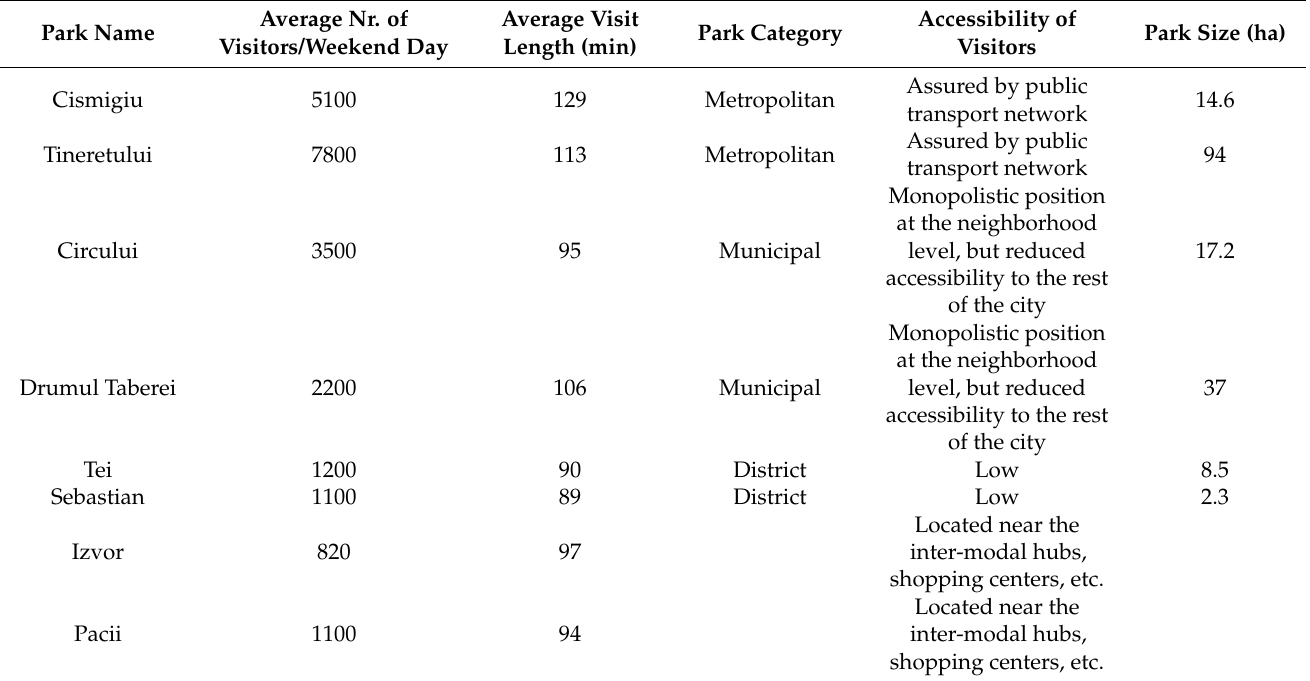
Table 1. Main characteristics of the analyzed parks (visitors and visit lenght after